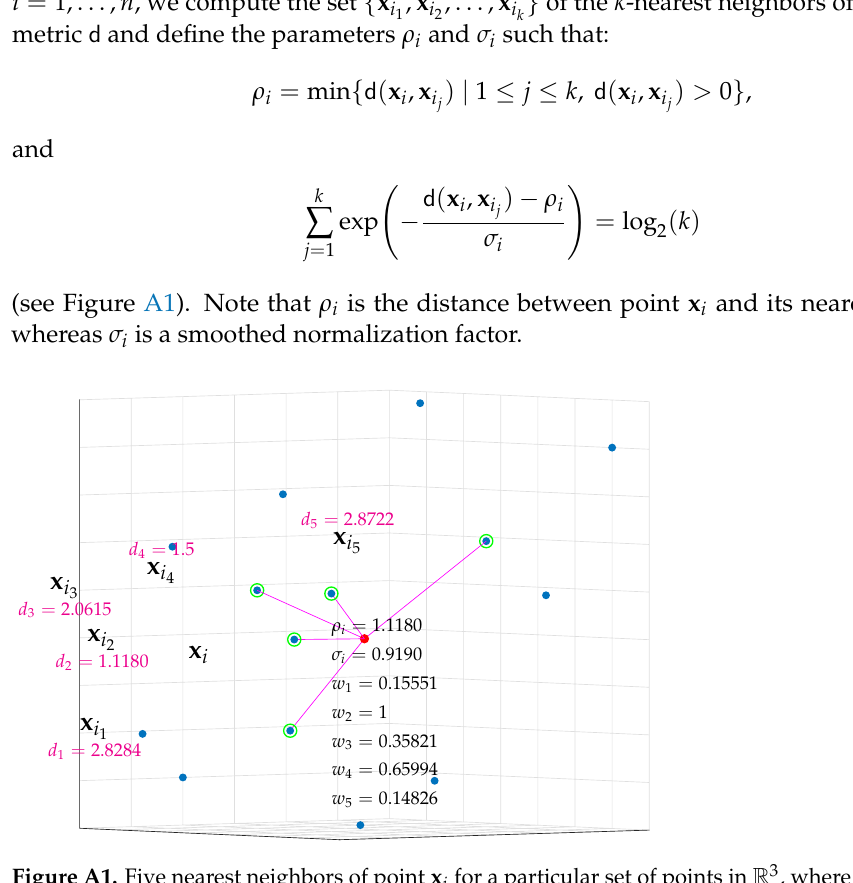
) and w = w ( x ) . The metric is the Euclidean distance. j i , x i j j